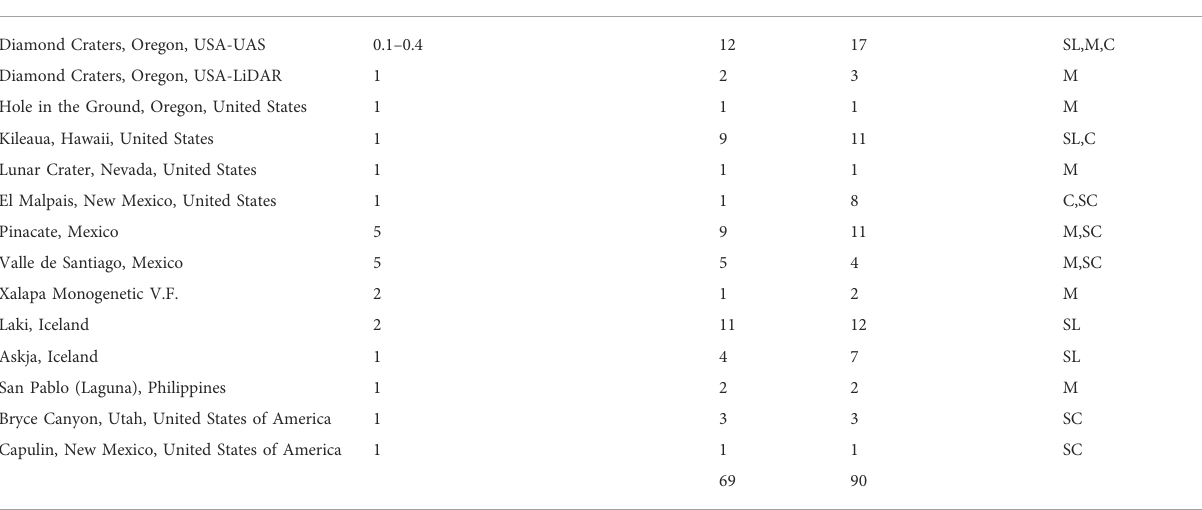
TABLE 1 Site list of current SMILES included landforms. This list does not include multimodal or complex landforms. SMILES landform site